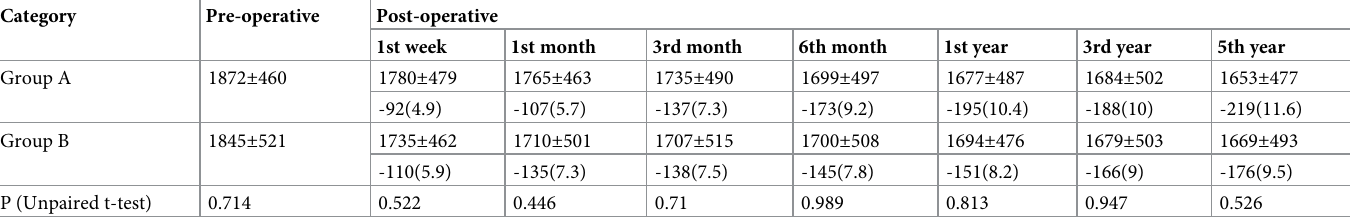
CECD = corneal endothelial cell density; SD = standard deviation; cell/mm2 = number of cells per mm